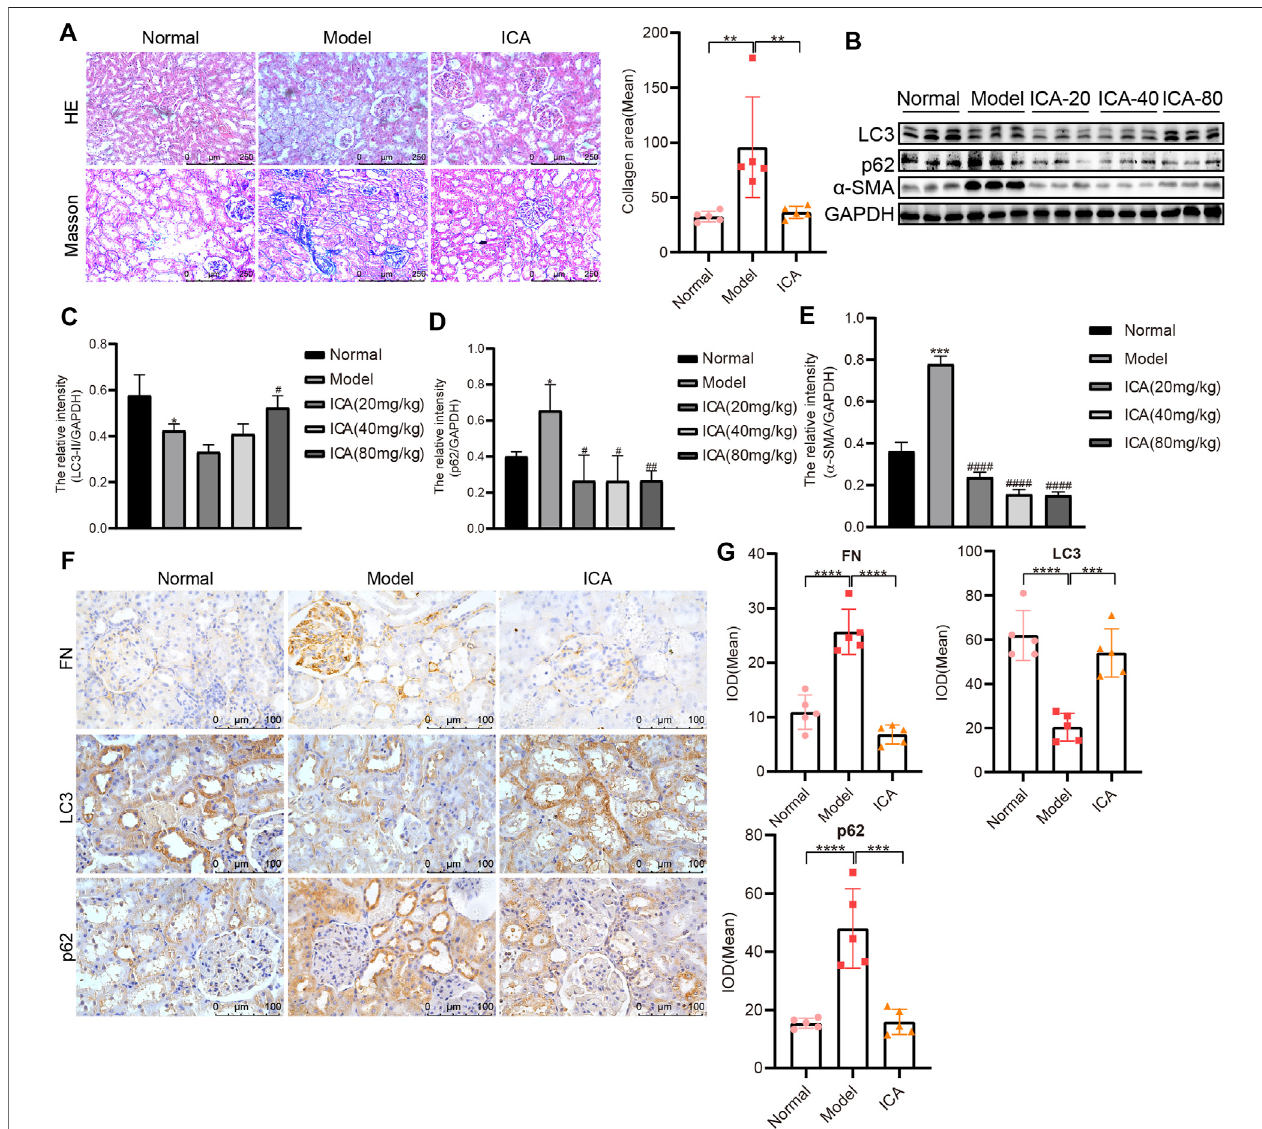
FIGURE 2 | ICA promotes autophagy and alleviates renal fi brosis in T2DN rats (A) Representative image of HE and Masson staining in Normal, Model and ICA + Model group (Scale bar: 250 μ m; original magni fi cation: × 200). ICA was administered at 80 mg/kg. Error bars represent SD; n (cid:1) 5; ** p < 0.01 (B) Results of LC3, p62, and α -SMA,asdeterminedbyWesternblot (C – E) RepresentativeWesternblotanalysisofLC3,p62,and α -SMAexpressioninratrenaltissues.ErrorbarsrepresentSD; n (cid:1) 3; * p < 0.05, *** p < 0.001, vs Normal; # p < 0.05, ## p < 0.01, #### p < 0.0001 vs Model (F) Immunohistochemical stainingof FN, LC3, and p62 inrat renal tissues (Scale bar: 100 μ m; original magni fi cation: × 400) (G) The mean IOD of LC3, p62, and FN expression was analyzed by IPP software. Error bars represent SD; n (cid:1) 5; *** p < 0.001, **** p < 0.0001.